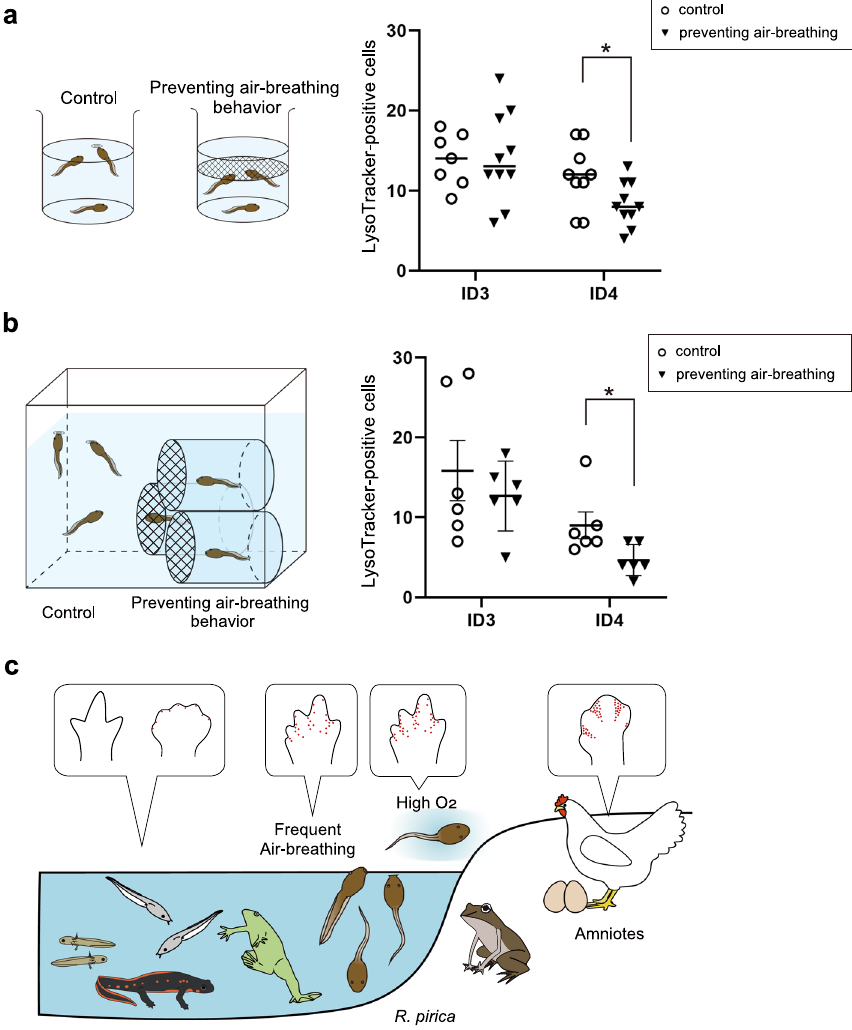
Fig. 3 Air- breathing is correlated with cell death in R. pirica limbs. a , b Quantification of LysoTracker–positive cells in ID3, or ID4 of the hindlimbs of early stage 36 R. pirica , reared overnight in a container without a net or with a net ( a ) or for 3 days in a tank without or with a tube covered with a net ( b ). Each symbol represents an individual specimen. Mean SEM. Two–tailed unpaired t –test. p < 0.05. c Schematic illustrating the life history + ∗ and limb development strategies of various amphibians. X. laevis and C. pyrrhogaster have aquatic tadpoles and no interdigital cell death [1, 17], while amniotes exhibit extensive interdigital cell death. Here we show that R. pirica has aquatic tadpoles, and exhibits interdigital cell death. The cell death observed in R. pirica tadpoles has been experimentally correlated to their frequent air–breathing behavior. Illustrations are modified after